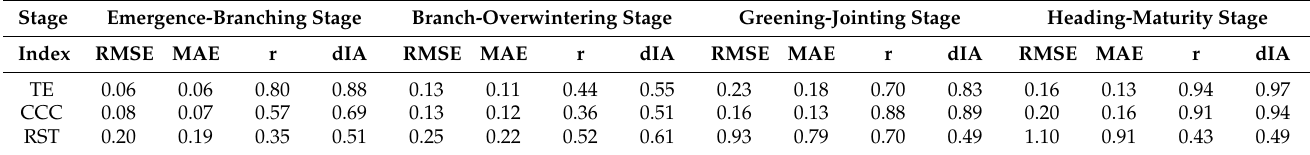
Figure 6. The estimated crop coefficient and actual crop coefficient during four growing stages. Table 3. The estimated precision index value of the results of three methods in each growth